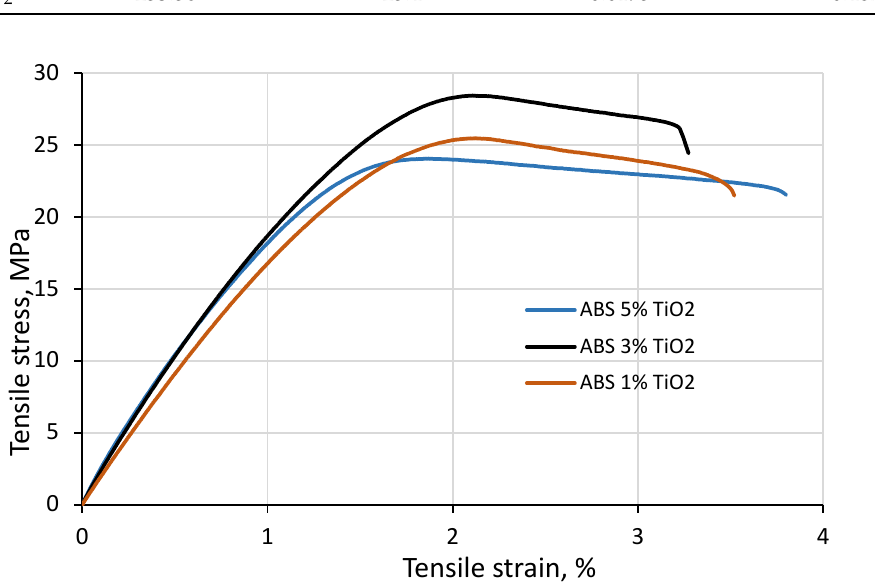
Figure 8. Tensile stress and strain diagram of non-irradiated 3D printed composite samples.